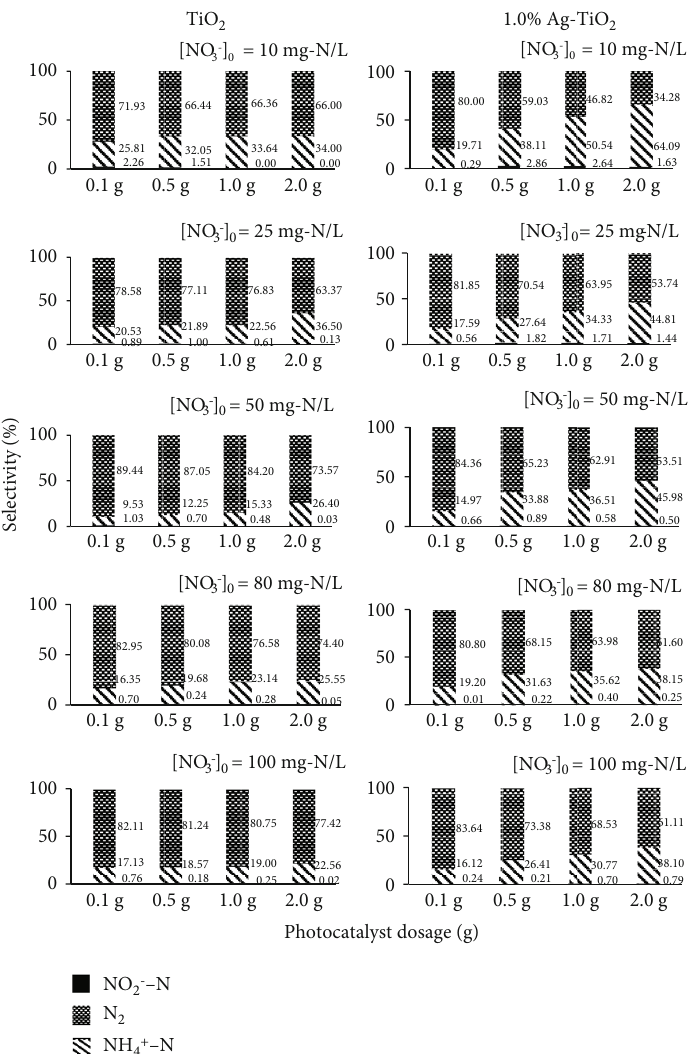
] and TiO and 1.0%Ag-TiO 0 2 3